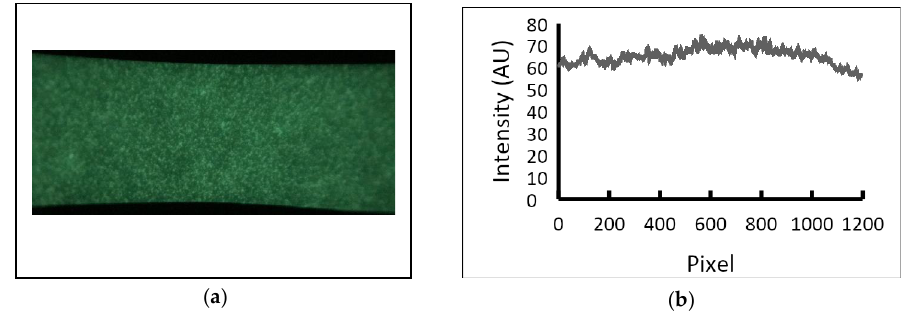
Figure 8. Spatial variability of camera sensitivity. ( a ) Image of a uniformly phosphorescent strip excited with an external light source and captured with our LFA reader attachment. ( b ) The image was analyzed with ImageJ to create an intensity profile.